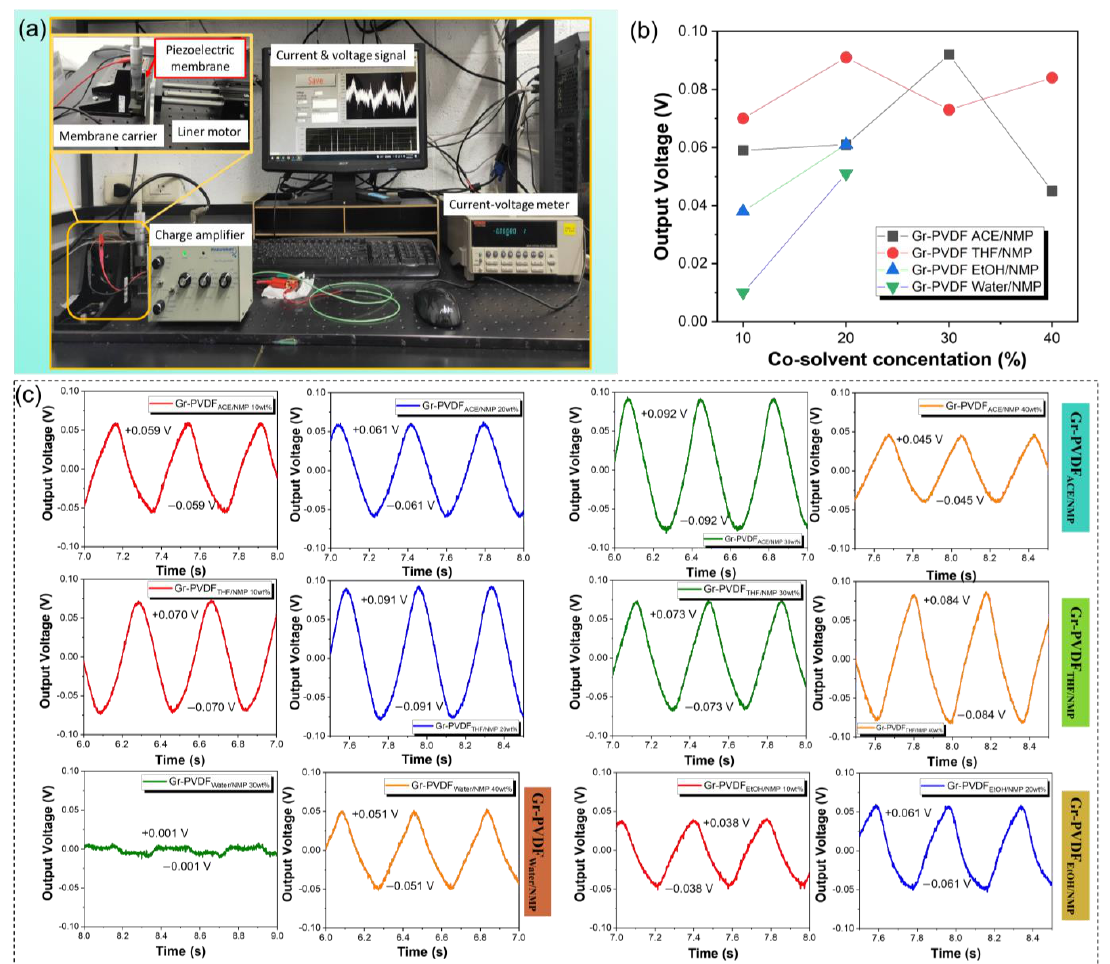
Figure 7. ( a ) Piezoelectric set-up instrument, ( b ) piezoelectric value (volt) of all composite film, and ( c ) the output voltage of graphene–PVDF piezoelectric nanogenerators composite film with different co-solvent at the input frequency of 1 Hz.